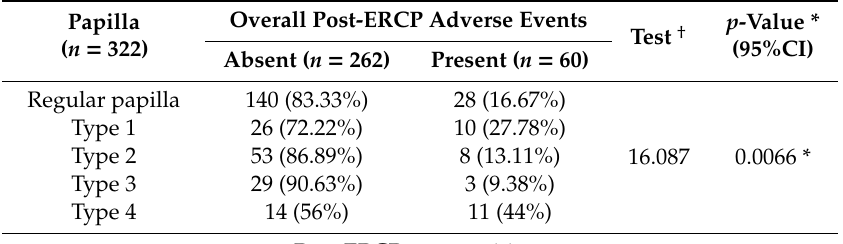
Table 3. Univariate analysis showing correlations between the di ff erent endoscopic appearances of the papilla and post-Endoscopic retrograde cholangiopancreatography (ERCP) adverse events rates. Papilla ( n = 322)